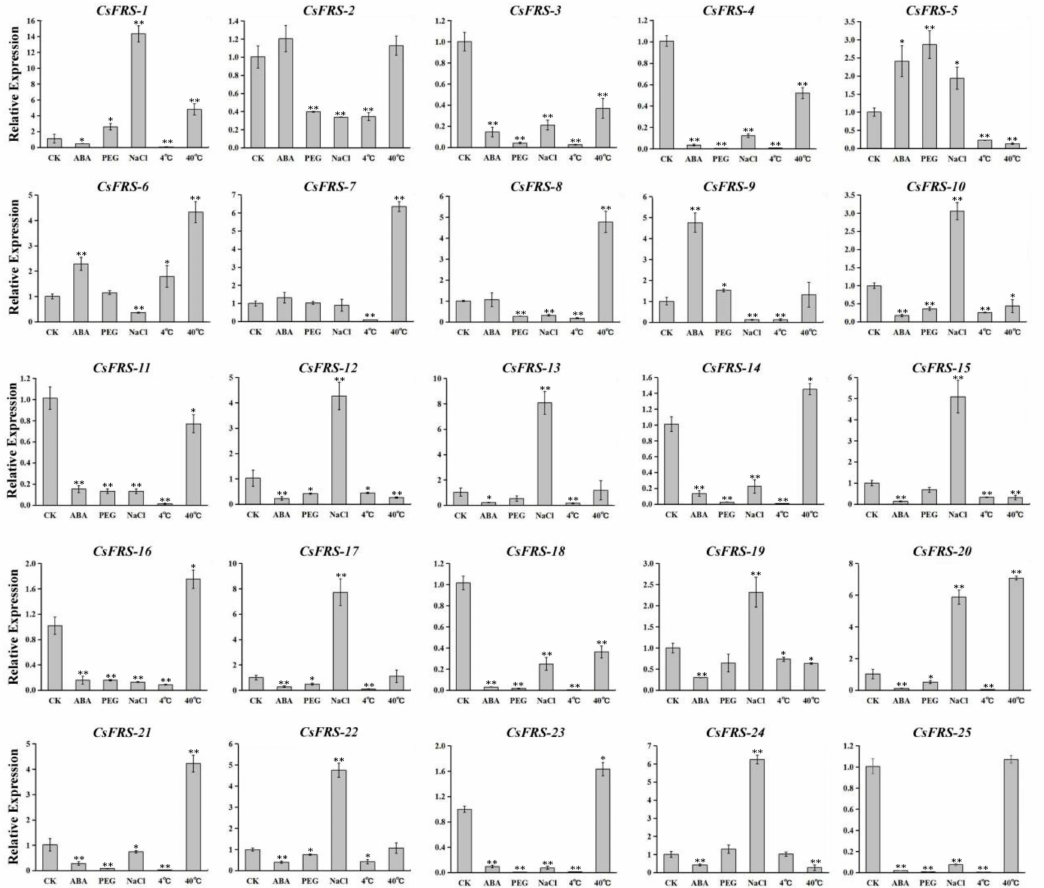
Figure 7. Expression analysis of the CsFHY3/FAR1 genes in tea plants under ABA, PEG, NaCl, low temperature, and high temperature treatments. The results are expressed as the mean ± standard deviation. The asterisks (* significant, and ** highly significant) denote significant variation ( p <